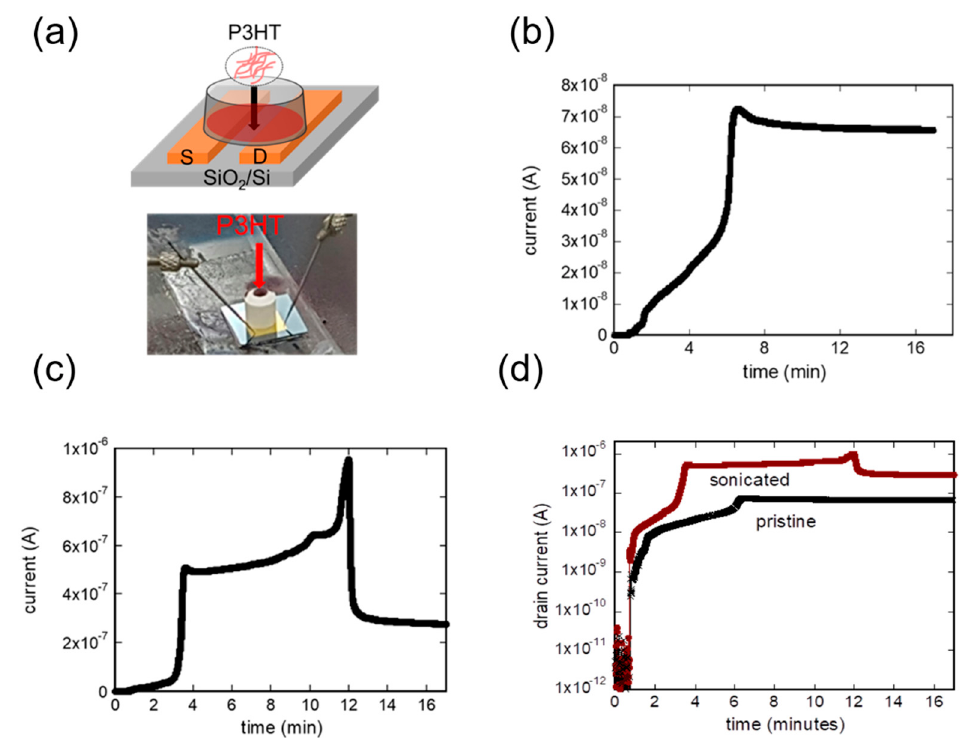
Figure 3. ( a ) A schematic diagram of the test structure for investigating the temporal evolution of the source (S)-drain (D) current. The ceramic tube confines a drop of P3HT solution (5 mg / mL) into the channel region during solidification. The inset shows an image of the experimental set-up. The channel length and the width of the device were 20 µ m and 8 mm, respectively. Temporal evolution of the source-drain current in ( b ) pristine and ( c ) sonicated P3HT solution. The concentration of the P3HT solution in chloroform was 5 mg / mL. The drain voltage was fixed at 0.3 V, and the measurement was carried out in an argon-filled glove box. ( d ) Comparison of temporal change in the drain current (logarithmic scale).